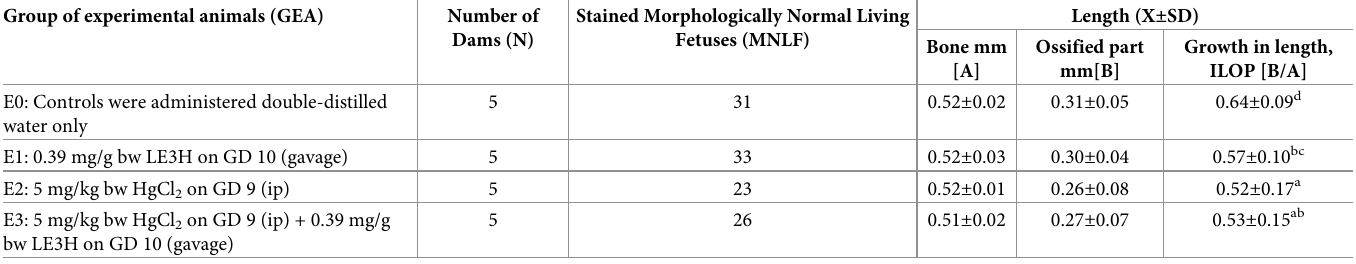
Table 5. Length of femur bone of M . musculus fetuses on Gestation Day (GD) 18 which previously were given 0.39 mg/g bw LE3H through gavage on GD 10 (E1), injected with 5 mg/kg bw HgCl 2 on GD 9 (E2), and administered 5 mg/kgbw HgCl 2 on GD 9 and then 0.39 mg/g bw LE3H on GD 10 (E3). Meanwhile, the controls (E0) were administered double-distilled water only. Group of experimental animals (GEA)